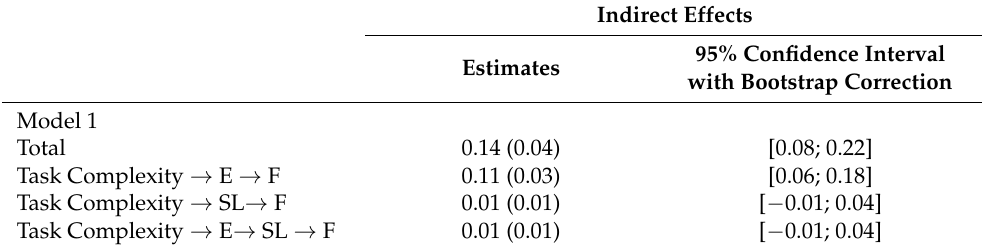
Table 8. Indirect effects of model 2.